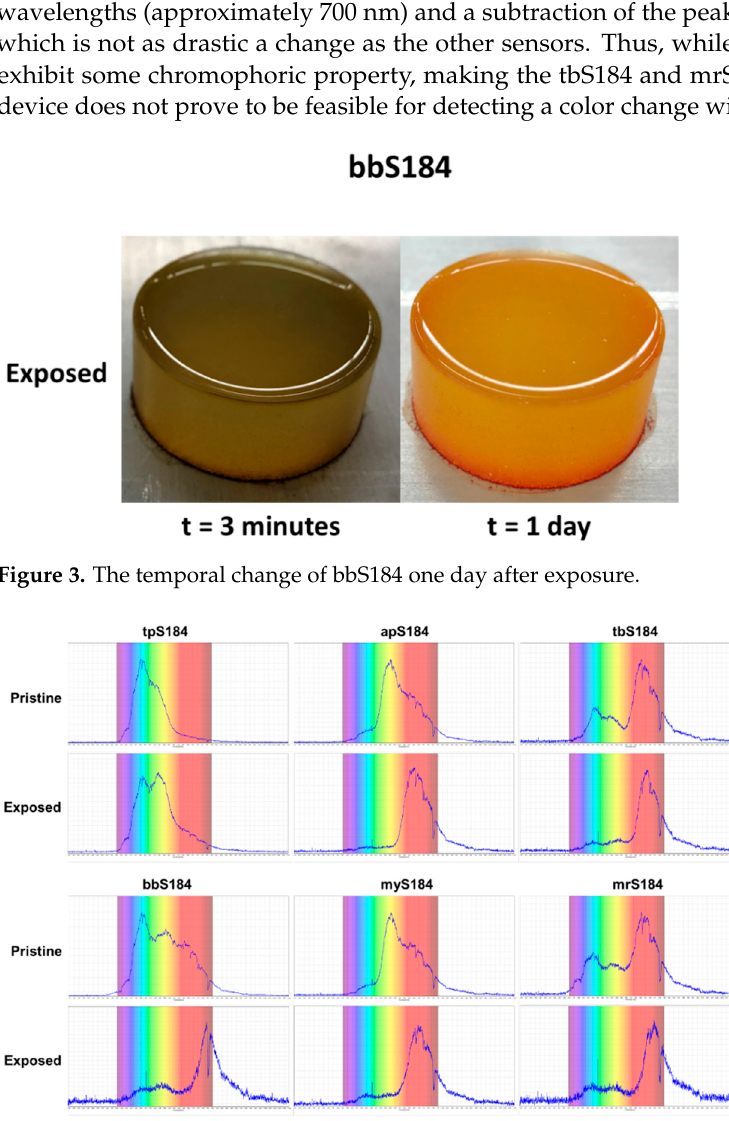
Figure 3. The temporal change of bbS184 one day after exposure.